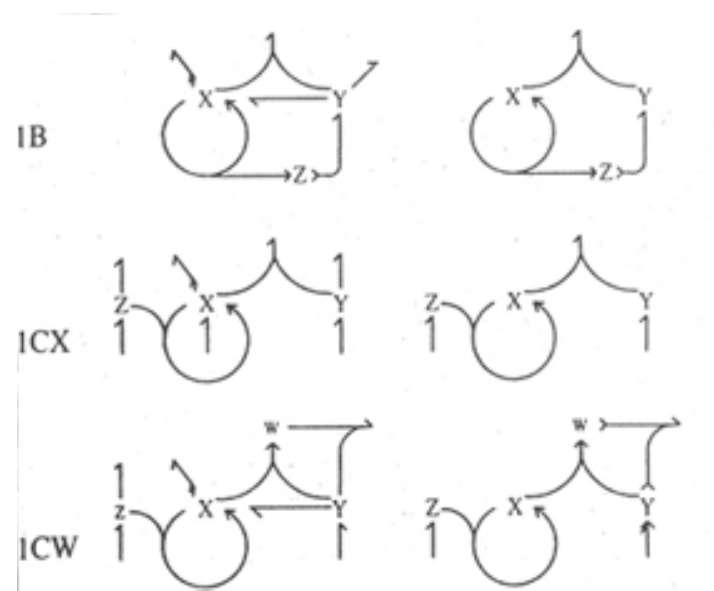
FIGURE 2. Diagrams of the Cycles 1B, 1CX, and 1CW (after[20]).